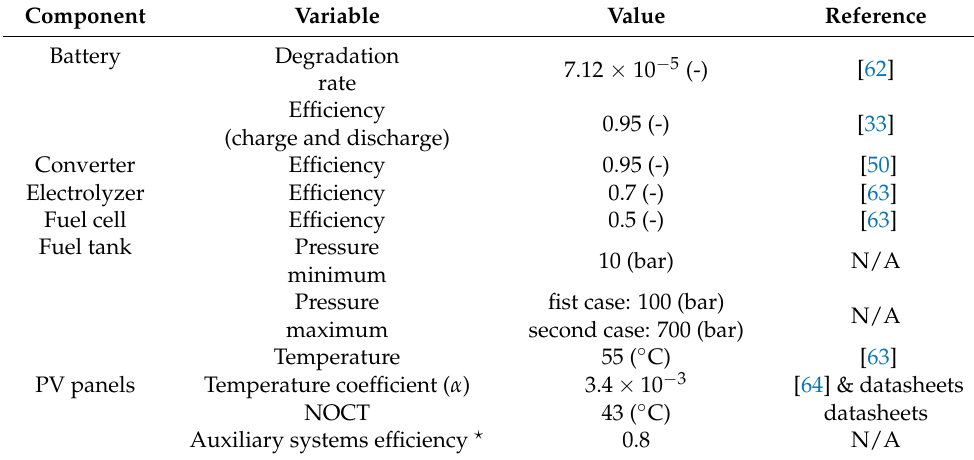
Table 2. Technical settings of the equipment.